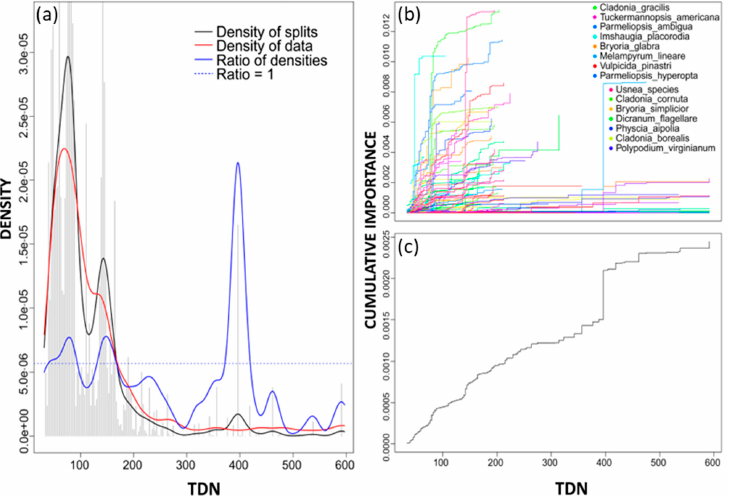
Figure 7. ( a ) Densities plot for TDN with binned split importance values (grey histogram bars), the density of data (red line), the density of splits (black line), the ratio of split-over-density (blue line). The dashed line is where the ratio = 1. Relatively greater community level changes (high split importance values) occur when the ratio of densities > 1; ( b ) species cumulative importance plot showing the cumulative distribution of splits importance scaled by R 2 . Each line represents an individual species, and the legend identifies the top 15 species experiencing the largest composition changes across the gradient; and ( c ) community cumulative importance plots calculated by the sum of weighted averages of all species in (b) and showing the overall pattern of compositional change for all species.